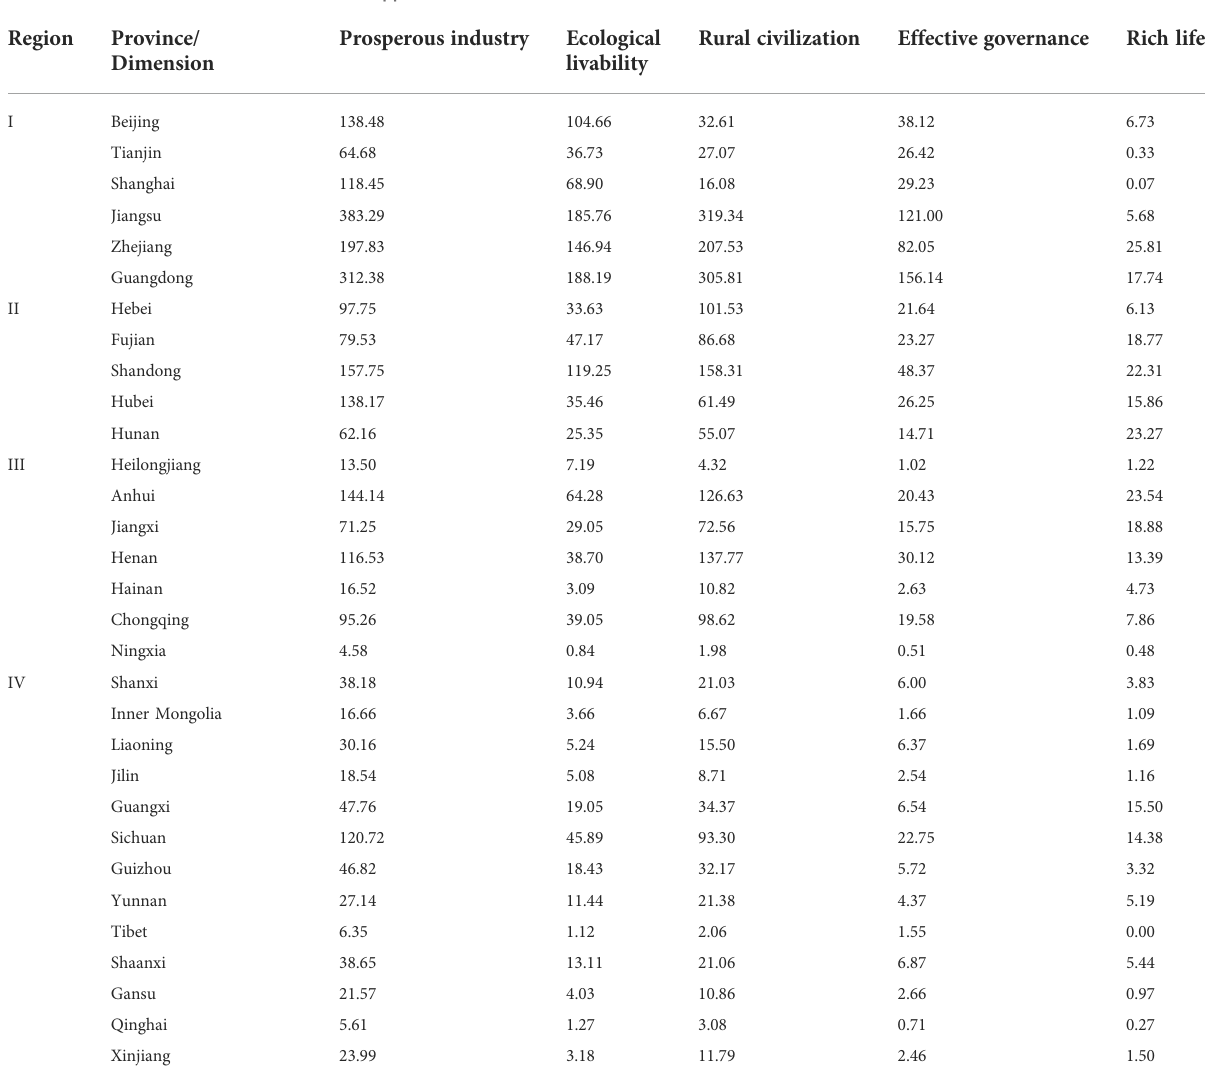
TABLE 11 Forecast of land transfer income support in 31 PLAD in 2025. Region Province/